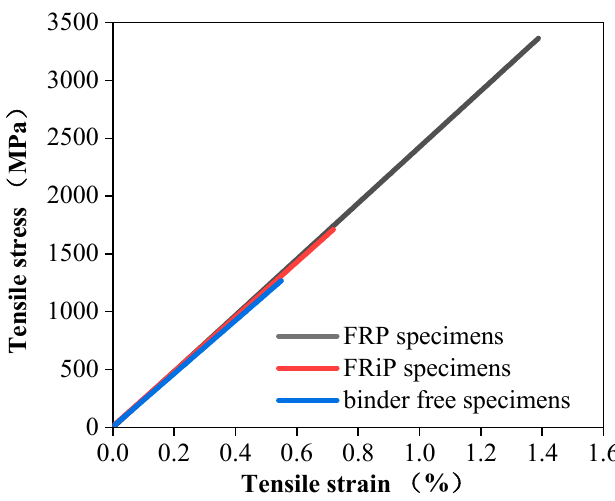
Figure 4. The tensile stress–strain curves of the three types of specimens. Table 3. The material properties of the fibers and FRP